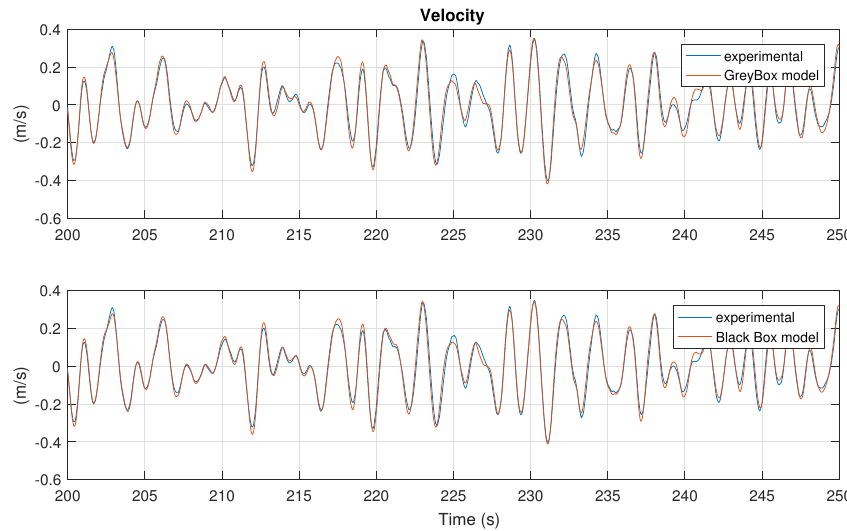
Figure 29. Validation for Grey box and Black box models using experiment 115, where waves have a pink multisine spectrum and also the actuator’s force has a pink multisine